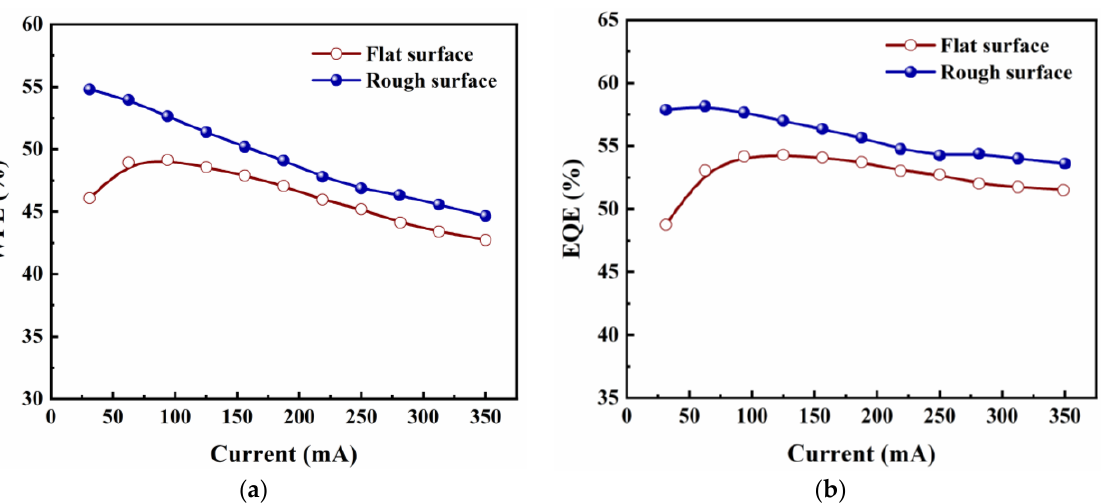
Figure 5. ( a ) WPE-I and ( b ) EQE-I curves of Si 3 N 4 -passivated LEDs with a flat surface and with a rough surface.